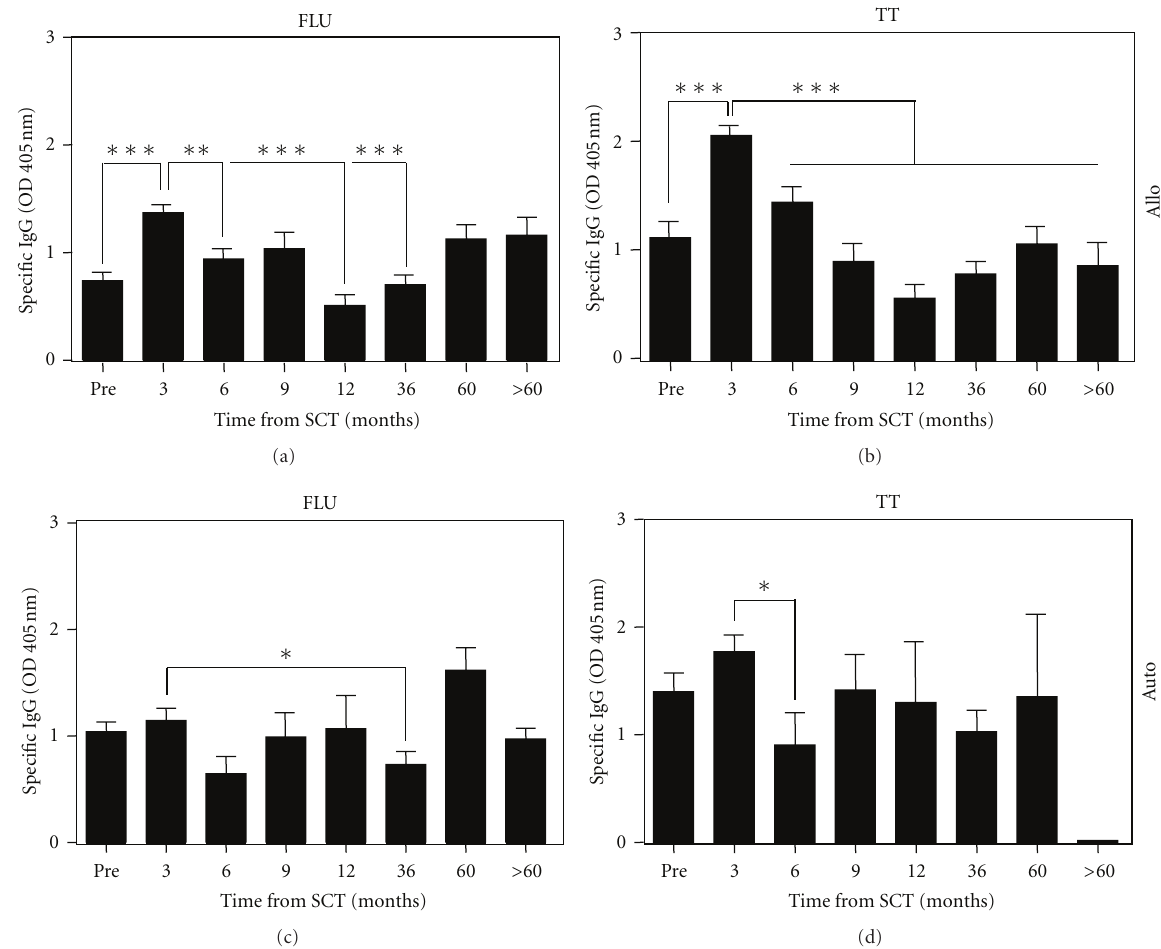
Figure 2: Time course of FLU- and TT-specific antibodies in MM patients undergoing alloSCT. Samples harvested in the frame of allo- and autoSCT were sorted according to time after transplantation. Only those patients were included into this analysis who had alloSCT or autoSCT, as maximum therapy. For the samples collected in the frame of alloSCT the group numbers of samples per time point were as follows: 30, 24, 24, 18, 19, 45, 33, and 20. For the samples collected in the frame of alloSCT, the group numbers of samples per time point were as follows: 25, 21, 10, 10, 4, 18, 2, and 2. Asterisks indicate significant di ff erences when compared to the time point “3 months” after SCT ( ∗∗ P < 0 . 01 and ∗∗∗ P < 0 .